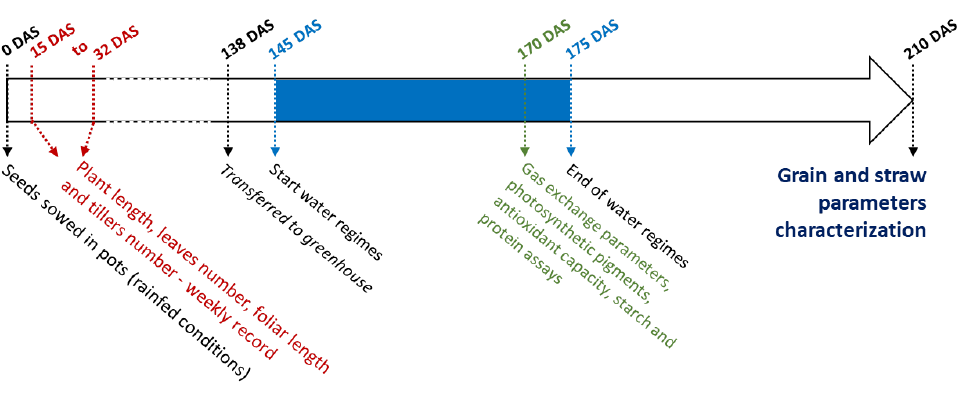
Figure 1. Timeline of the field trial.